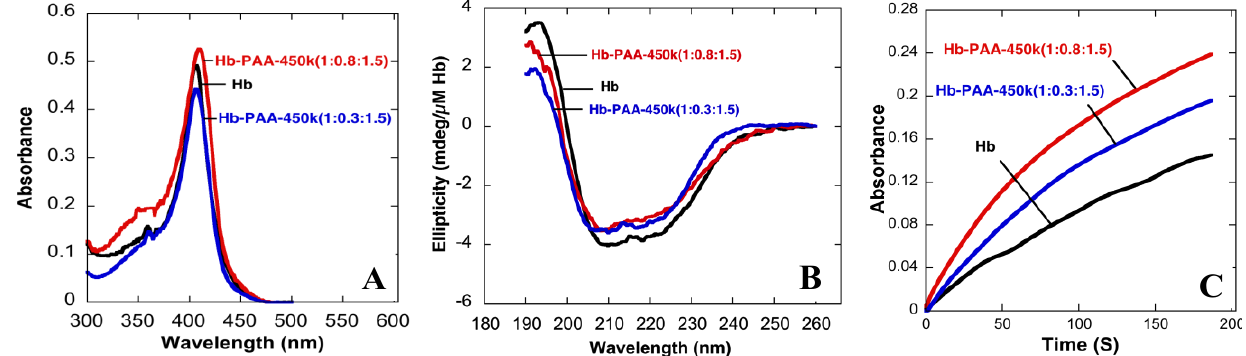
Figure 2. ( A ) Absorbance spectra of Hb, Hb-PAA-450k(1:0.8:1.5) and